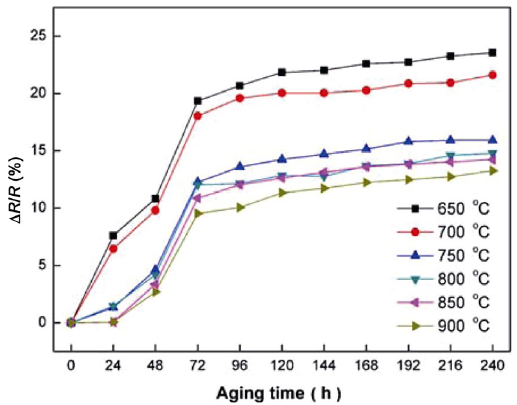
Fig. 10 Relationship between the aging values and the aging time of MCNO films at different annealing